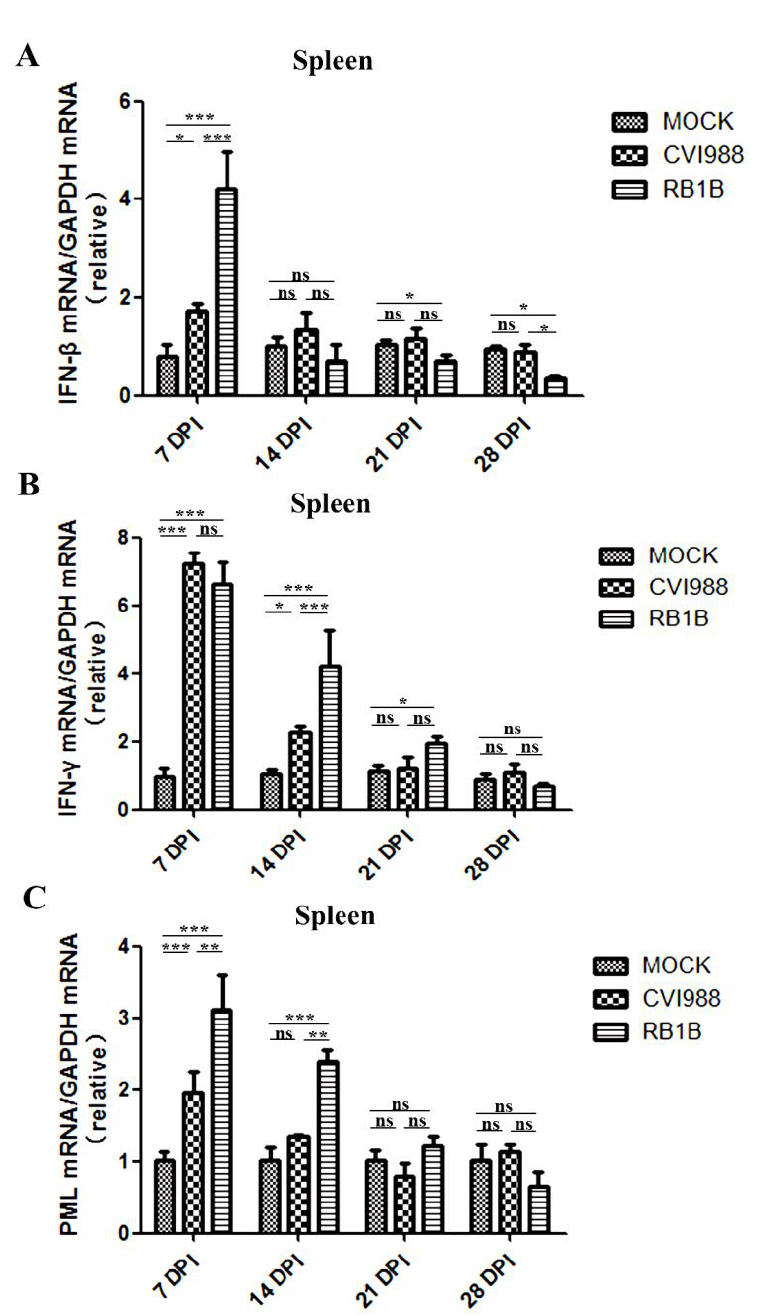
Figure 2. IFN- β , IFN- γ , and PML transcripts in the spleen inoculated with MDV/CVI988 and MDV/RB1B. ( A ): Specific IFN- β transcripts in the spleen; ( B ): specific IFN- γ transcripts in the spleen; ( C ): specific PML transcripts in the spleen. The statistical results are shown as the means ± SD of each experimental group. Statistical significance between each two experimental groups (CVI988 vs. MOCK, RB1B vs. MOCK, CVI988 vs. RB1B) was assessed by t -test (* p < 0.05; ** p < 0.01; *** p < 0.001; ns, no significance).